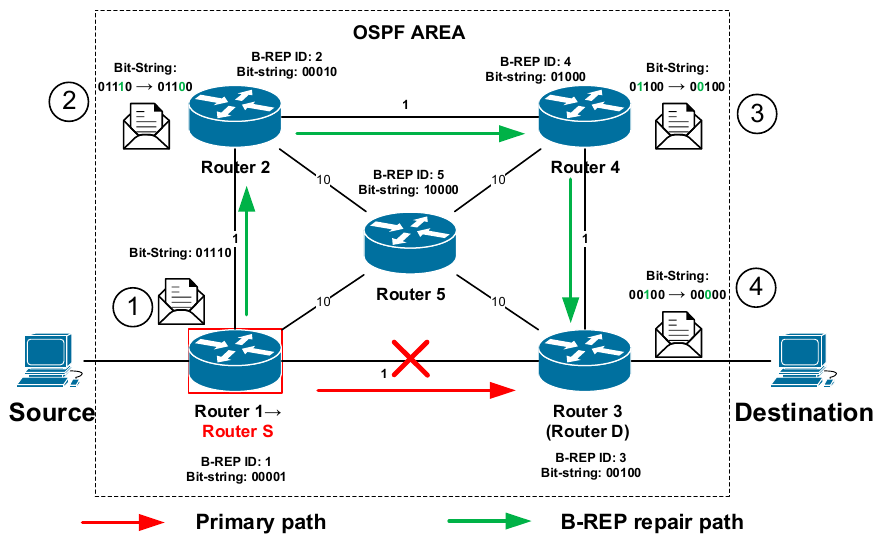
Figure 9. Example of a modified bit-string.